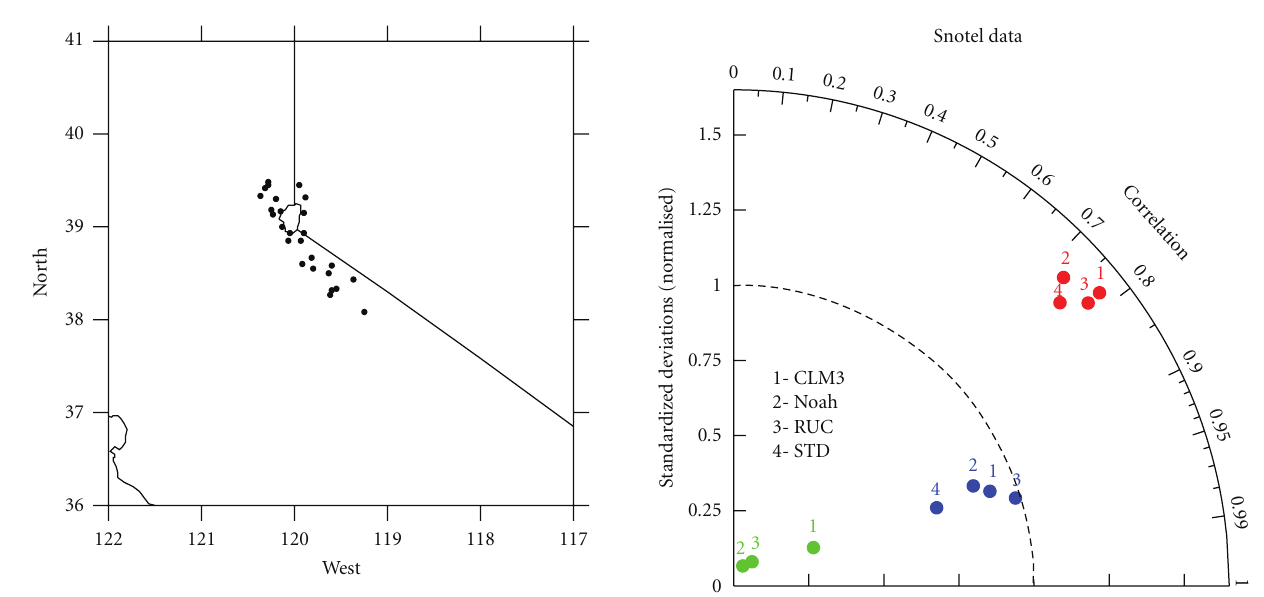
southern (northern) WUS [4].